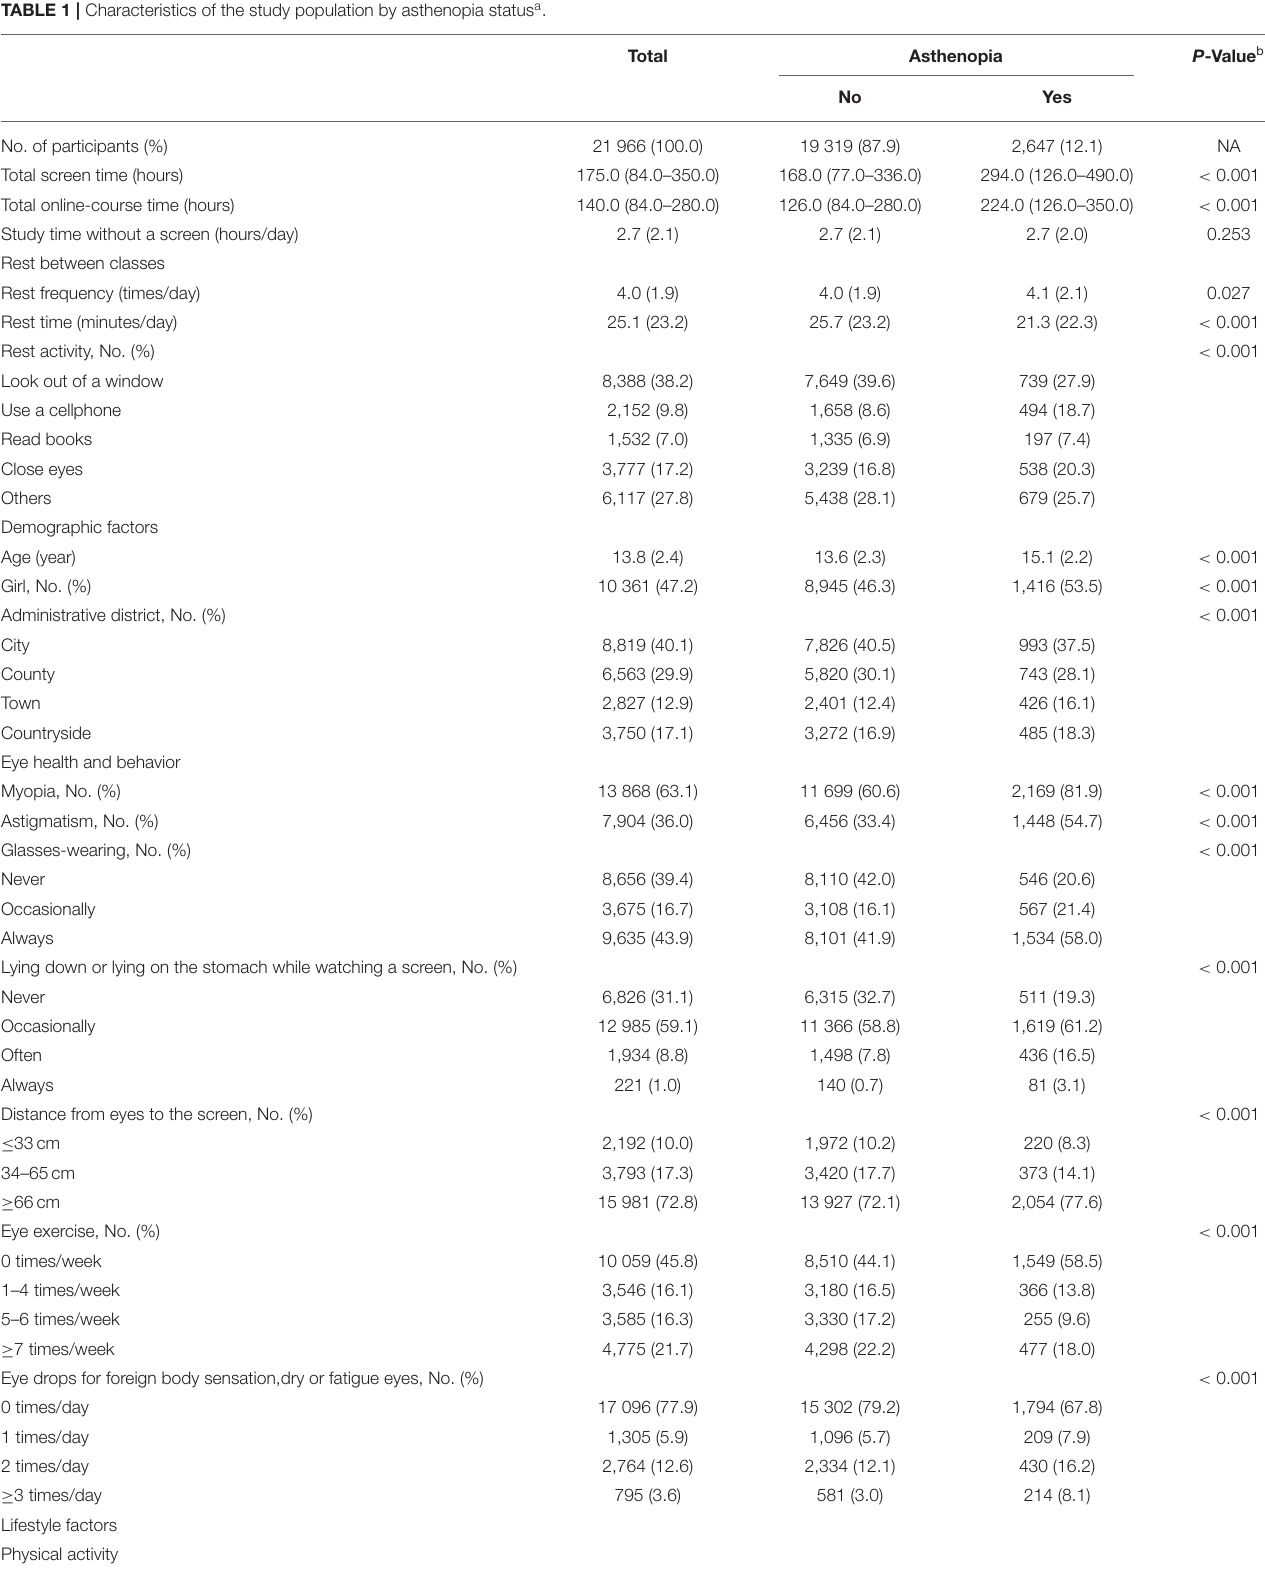
TABLE 1 | Characteristics of the study population by asthenopia status a .